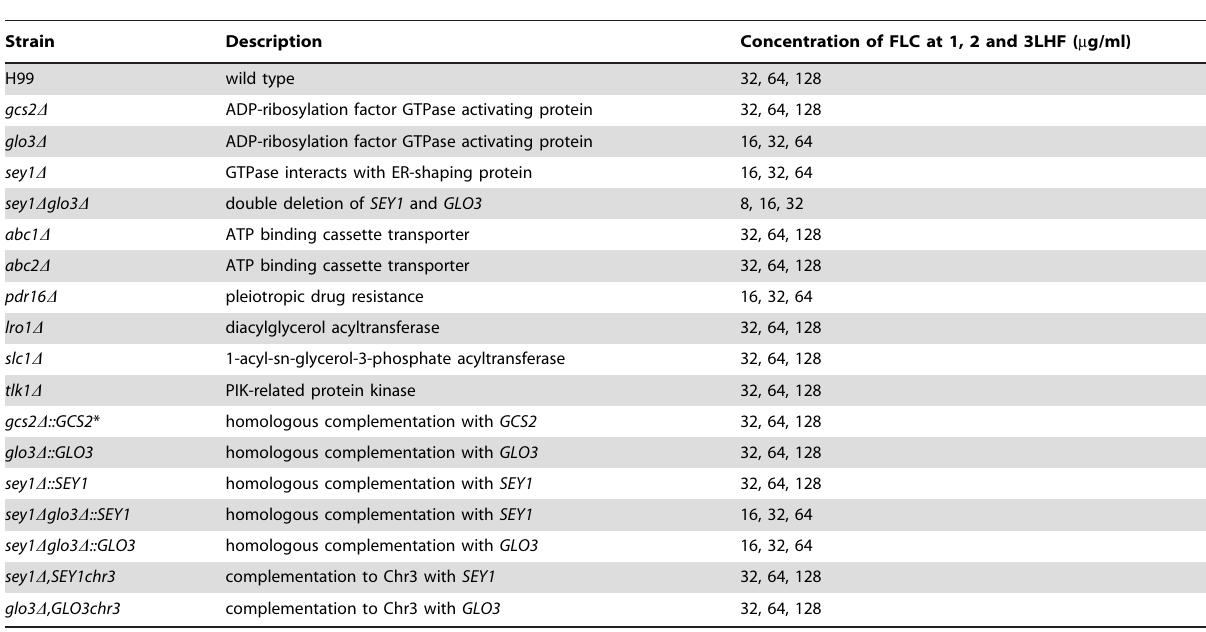
Table 1. List of strains and their levels of heteroresistance.